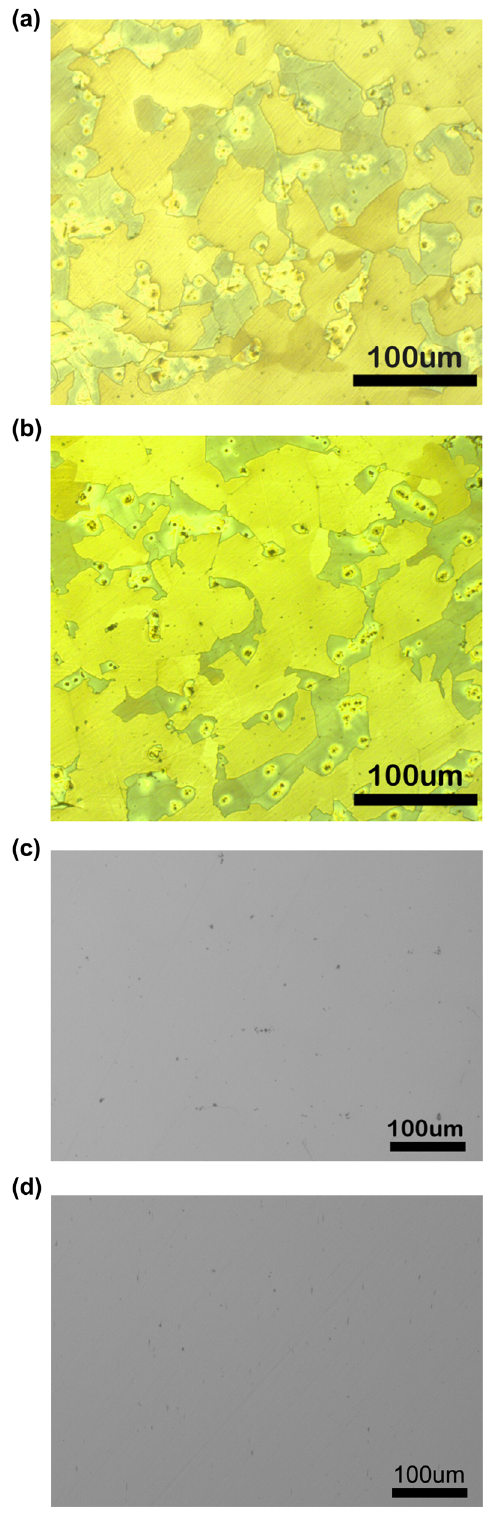
Figure 8: OM microstructure under casting ( a ) and annealing ( b ) conditions. Precipitation distribution under casting ( c ) and annealing ( d ) conditions.